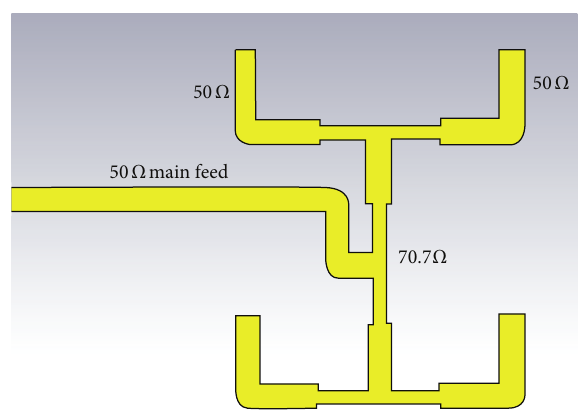
Figure 5: Corporate-feed network for 2 × 2 array.